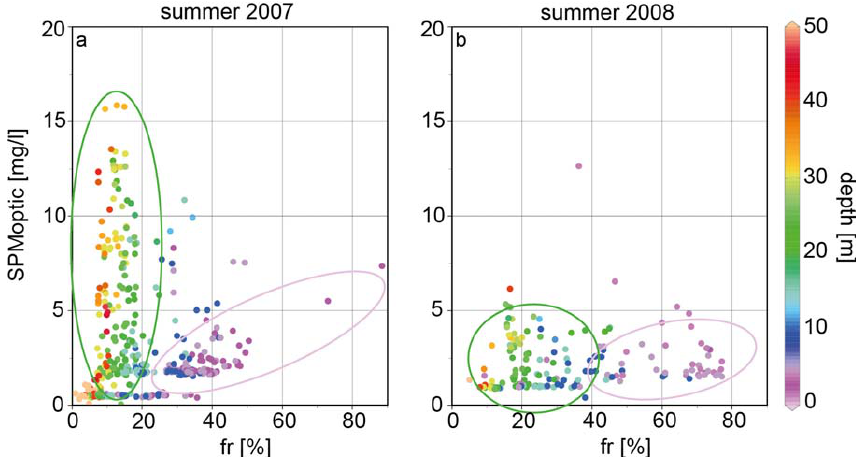
Fig. 8. Scatter plot of SPMoptic and riverine fraction along the section in Fig. 4 during TD XII (summer 2007) and TD XIV (summer 2008). Green circles mark the typical fr/SPMoptic relation for the bottom nepheloid layer. Purple circles mark the characteristic relation for the riverine-influenced surface nepheloid